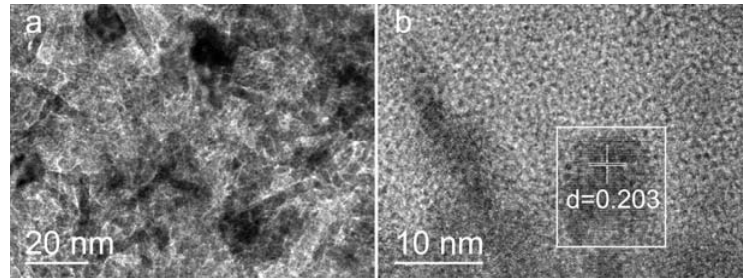
Figure 3. TEM profiles of reduced oxygen carriers.